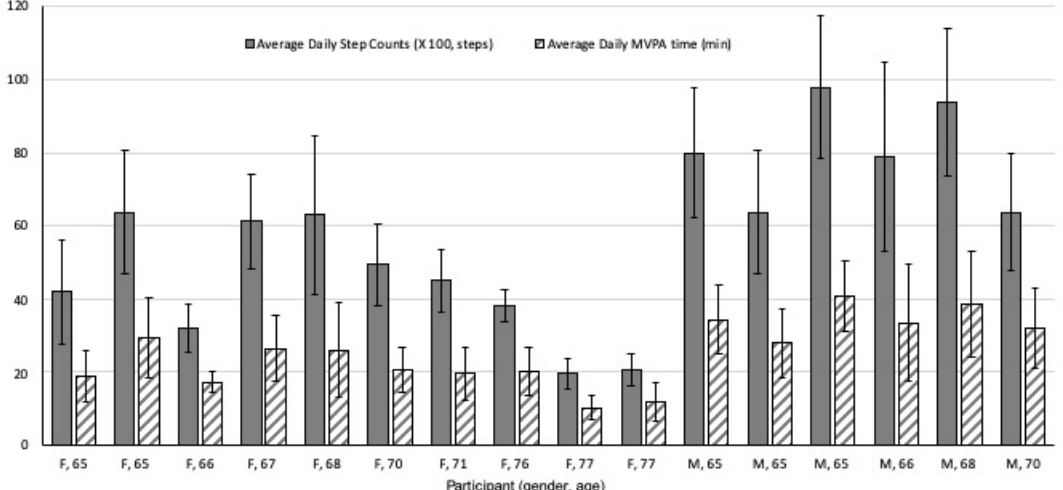
Figure 1. Averages of daily step counts and moderate and vigorous physical activity (MVPA) times for each participant.